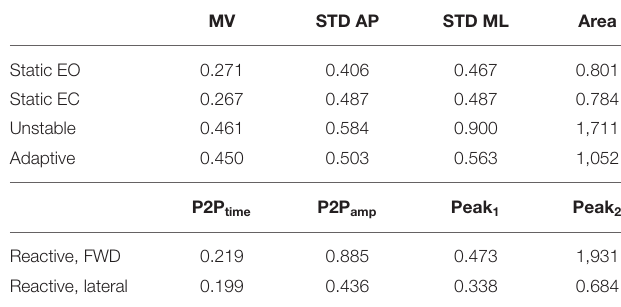
TABLE 3 | Square root of the variance of the residuals,